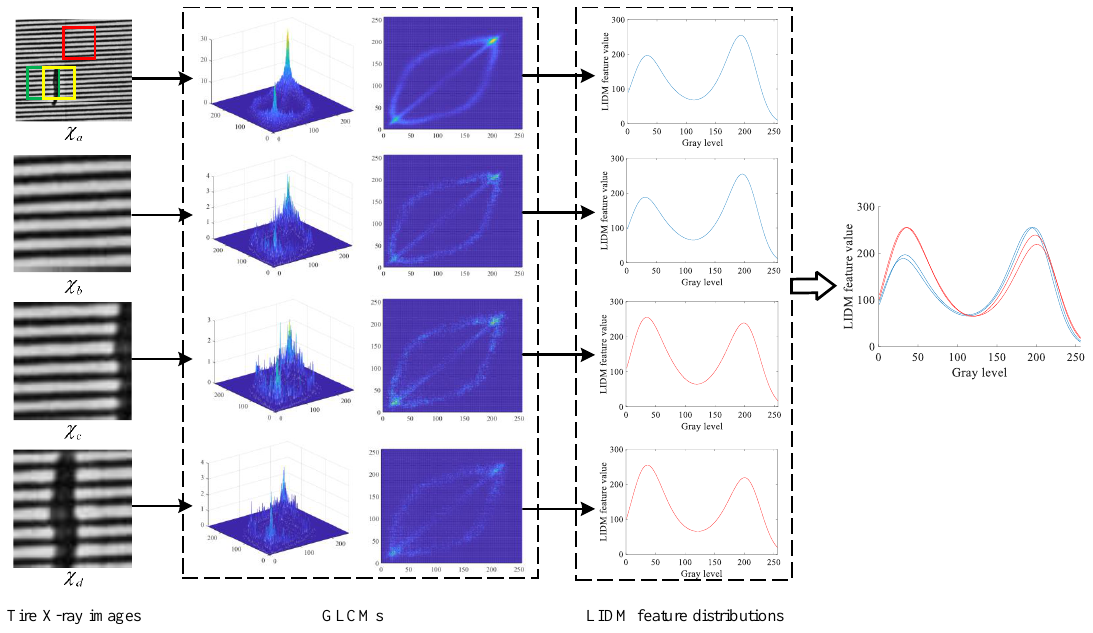
Figure 5. Comparison of characteristics of defects by LIDM feature